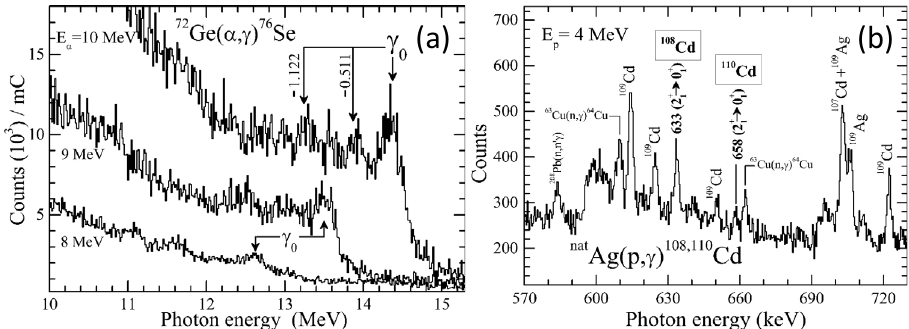
Figure 1. Typical γ -singles spectra measured in the present work for 72 Ge( α, γ ) 76 Se (left) and 107 Ag( p, γ ) 108 Cd (right). For details see in the text of section